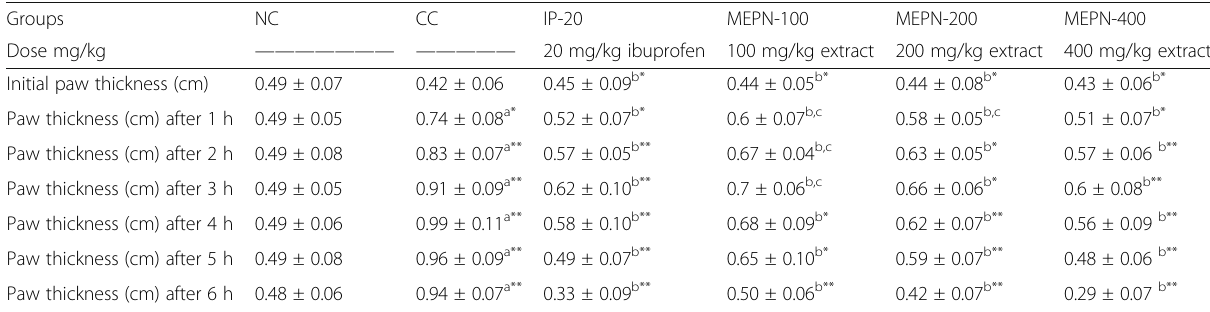
Table 2 Anti-inflammatory effect of Phyllanthus niruri methanolic extract on carrageenan induced changes in paw thickness in experimental rats Groups